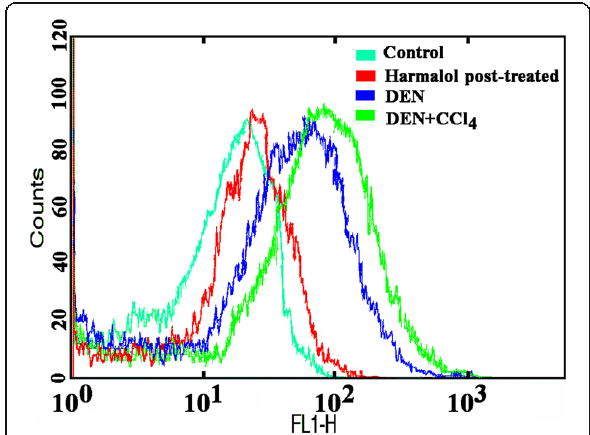
Fig. 9 ROS detection of four liver sections of different groups of control, harmalol post-treated, DEN and DEN+CCl 4 by using DCFH- DA, fluorescent probe by flow cytometric